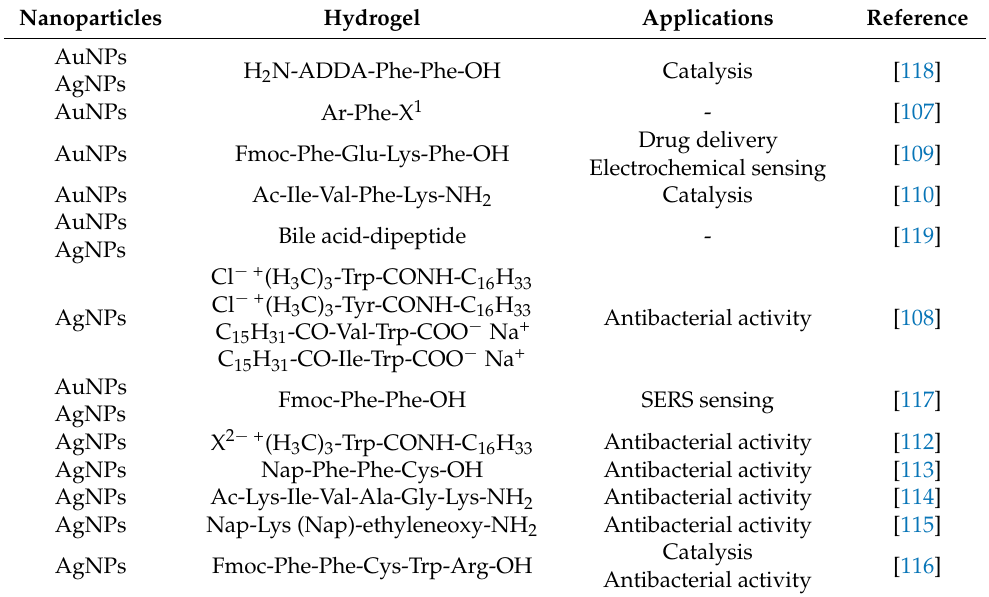
Table 3. Summary of advancements with peptide-based metal nanoparticle–hydrogel